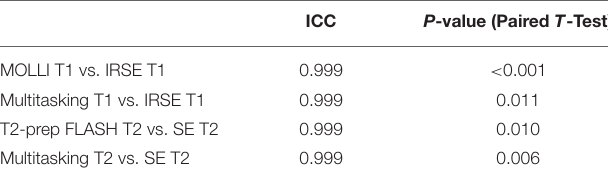
TABLE 1 | Intraclass correlation coefficient (ICC) and P -values of the paired t -test for comparison analysis between cardiac mapping methods and the gold standard and reference values across vials in the ISMRM/NIST